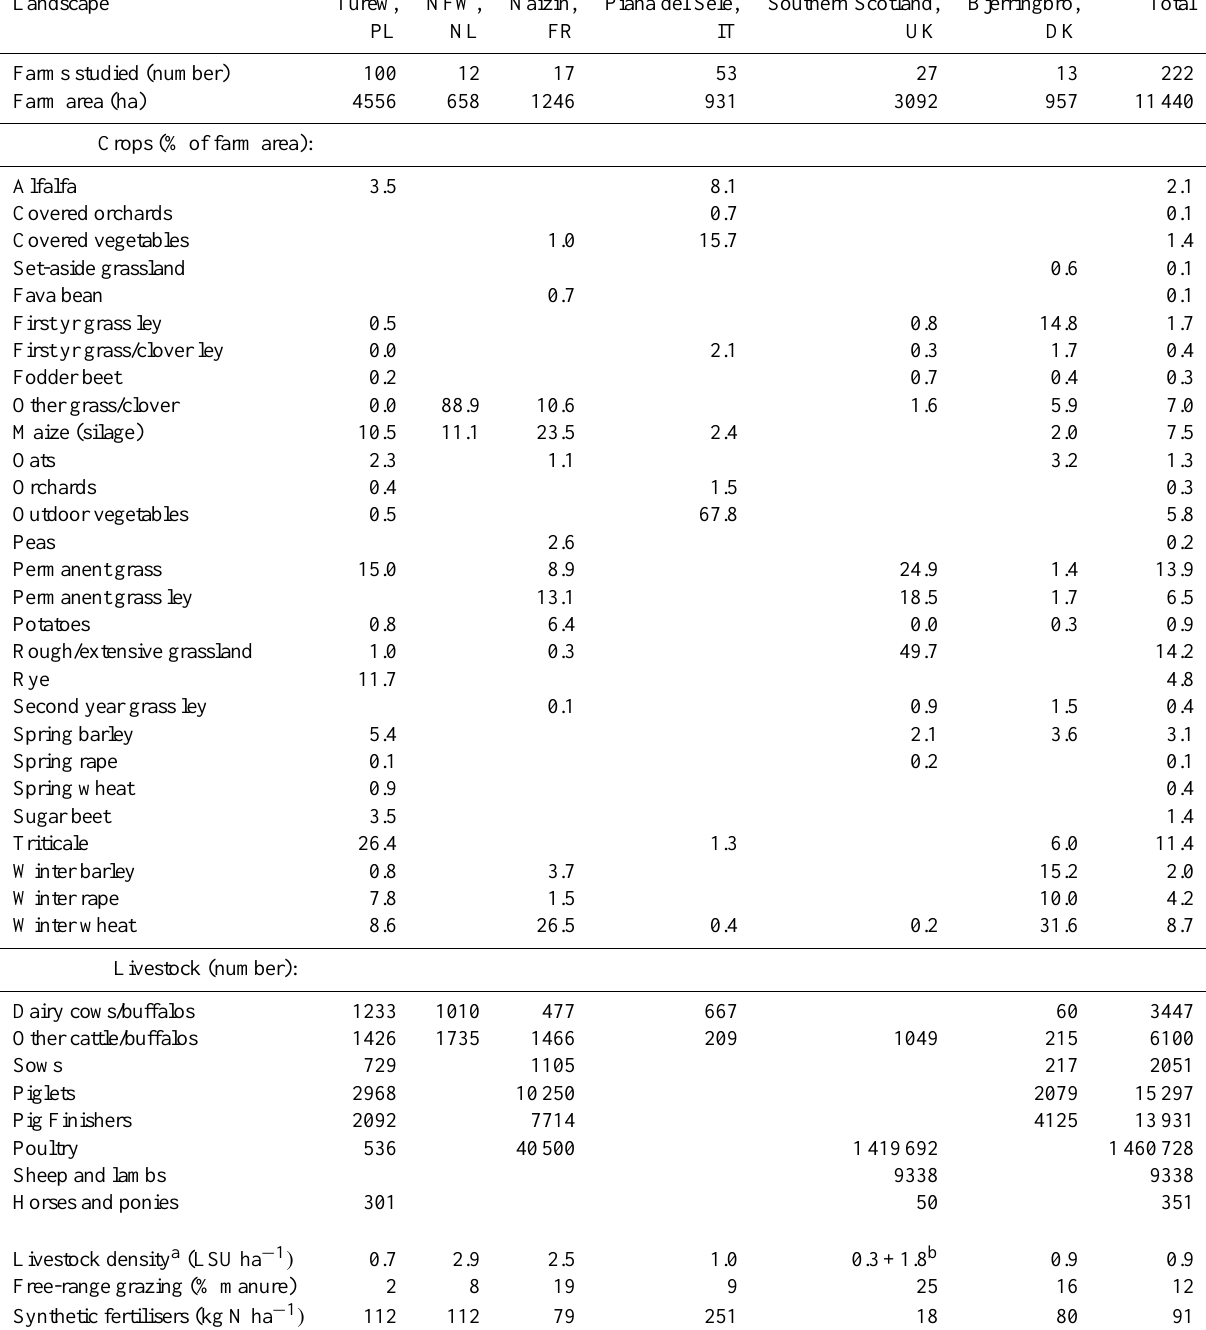
Table 3. Agricultural land use and livestock production characteristics of the study landscapes. Landscape